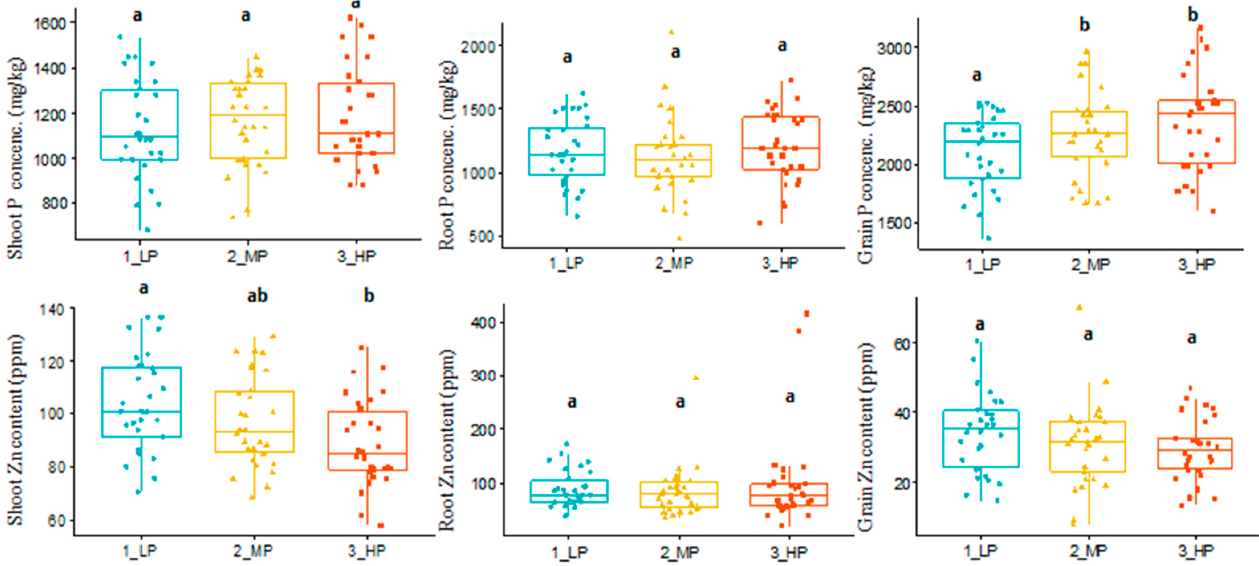
Figure 3. Phenotypic distribution of phosphorus (P) and zinc (Zn) contents of shoot, root, and grains from the field environment under varying soil phosphorus levels. Box plot displays the median of each group bounded by the first and third quartile, where the X -axis is soil phosphorus concentrations, with 1_LP = no-P application, 2_MP = 10 kg P 2 O 5 ha − 1 , and 3_HP = 60 kg P 2 O 5 ha − 1 . Letters above each box plot denote similarity among groups as per Tukey’s honestly significant difference comparison test ( α ≤ 0.05). Means with the same letter are not significantly different.